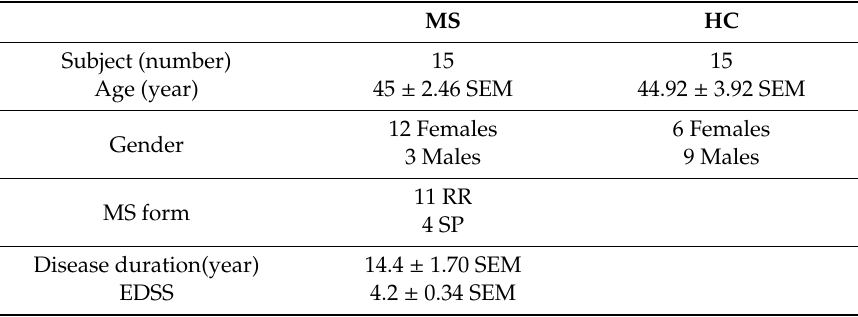
Table 1. Demographic and clinical characteristics of patients with multiple sclerosis (MS) and healthy control subjects (HC) enrolled into the study. (SP: secondary progressive, RR: relapsing-remitting, EDSS: Expanded Disability Status Scale, SEM: standard error of